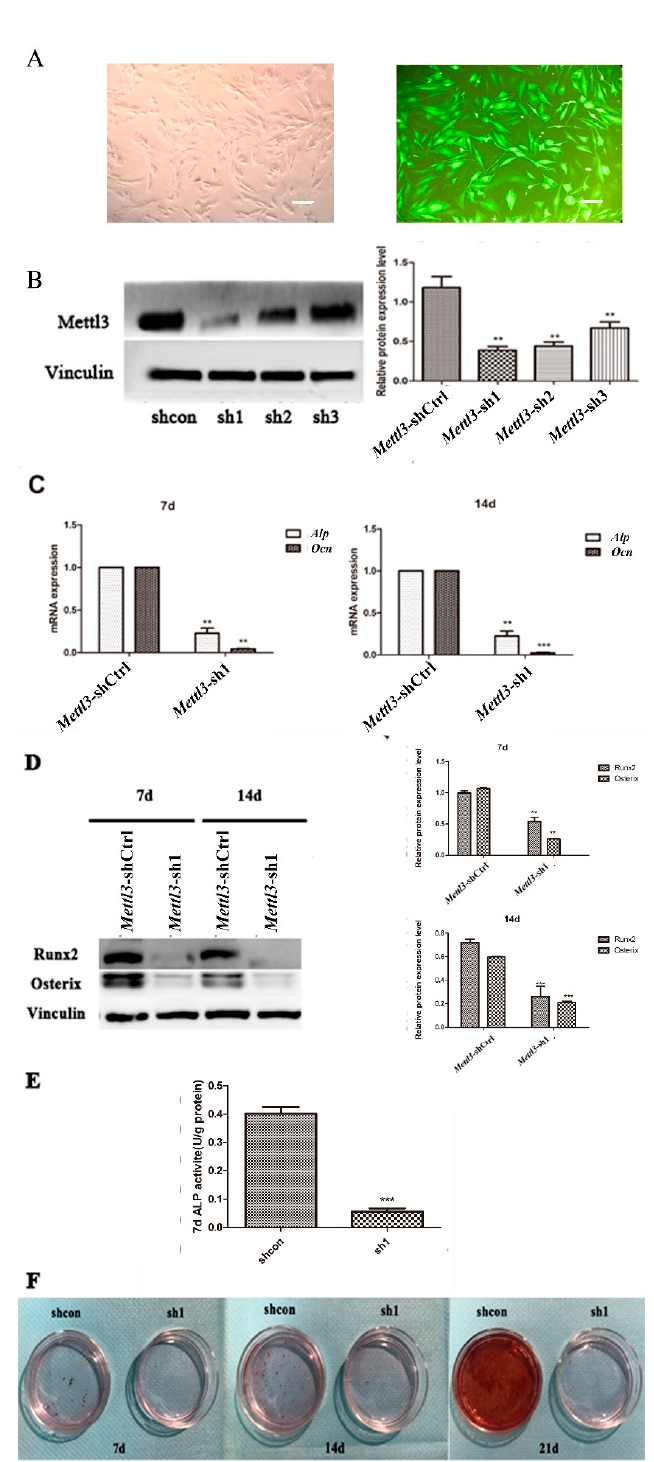
Figure 3. Effect of Mettl3 knockdown on the osteogenic differentiation potential of BMSCs. ( A ) A green fluorescence protein marker was used to determine the transfer efficiency of Mettl3 knockdown in BMSCs. After transfection for 72 h, the cells were observed under a microscope (on the left). The right image is an immunofluorescence image taken at the same time. The “black” scale bars represent 100 µ m (original magnification × 100). ( B ) The expression level of Mettl3 was determined using Western blotting in the Mettl3 -shRNA and Mettl3 -shCtrl groups. Vinculin was used as an internal control. The band intensities were analyzed using ImageJ software. ( C ) The mRNA expression levels of Alp